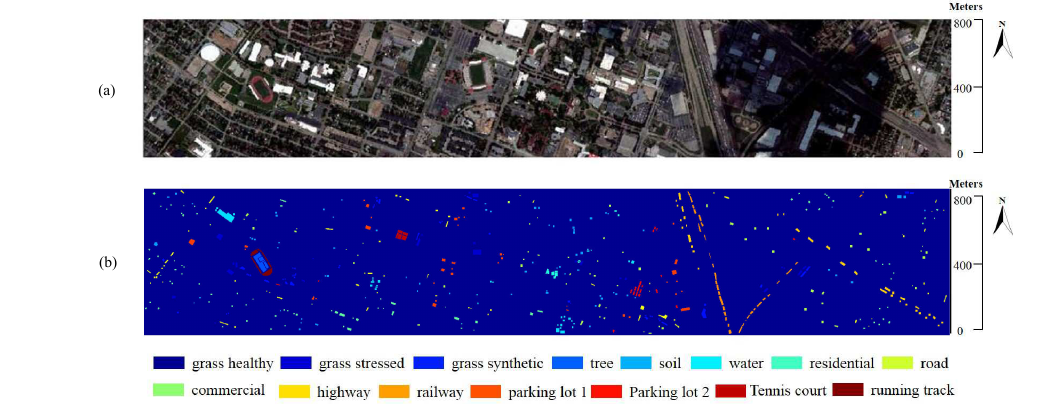
Figure 7. University of Houston data. ( a ) Three band false color composite and ( b ) ground truth data with 15